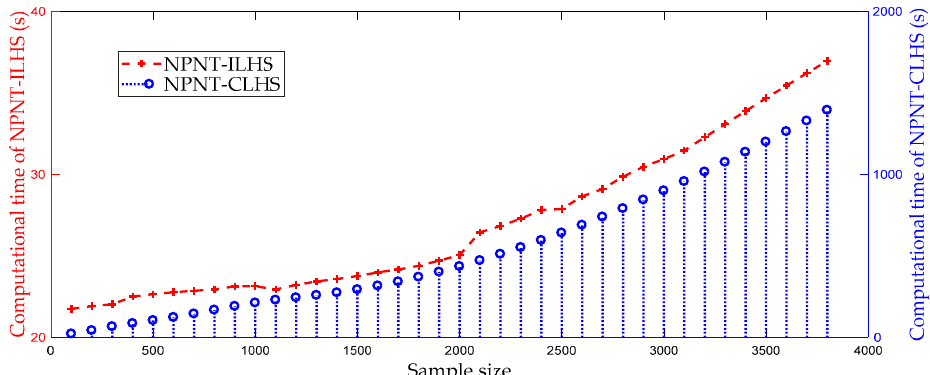
Figure 9. The average values of FHSIs of DC bus voltage obtained by using ILHS and CLHS methods.